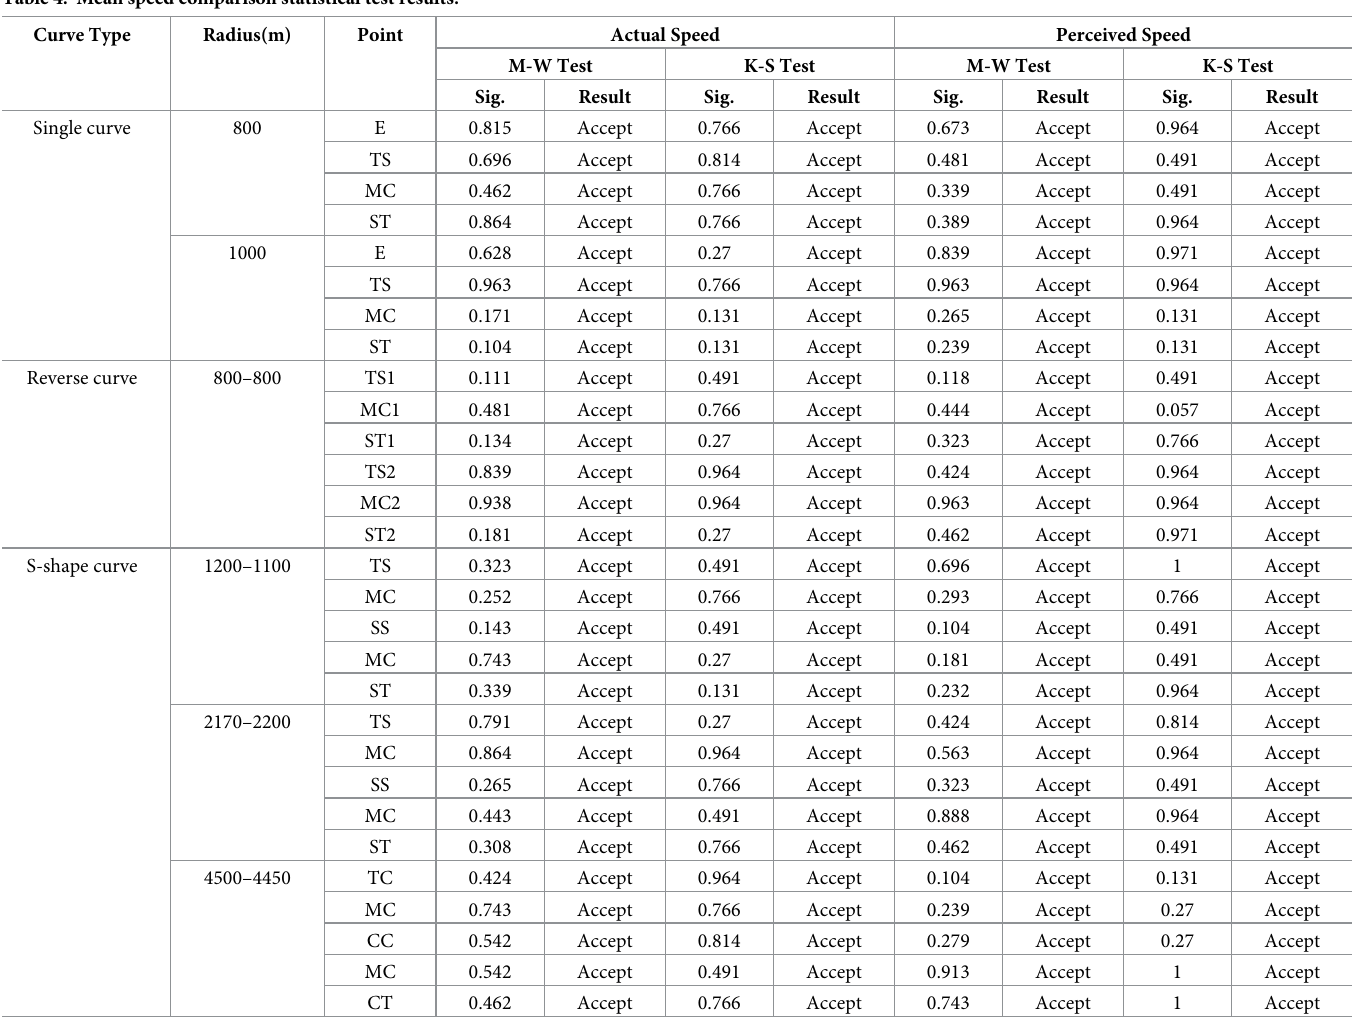
Table 4. Mean speed comparison statistical test